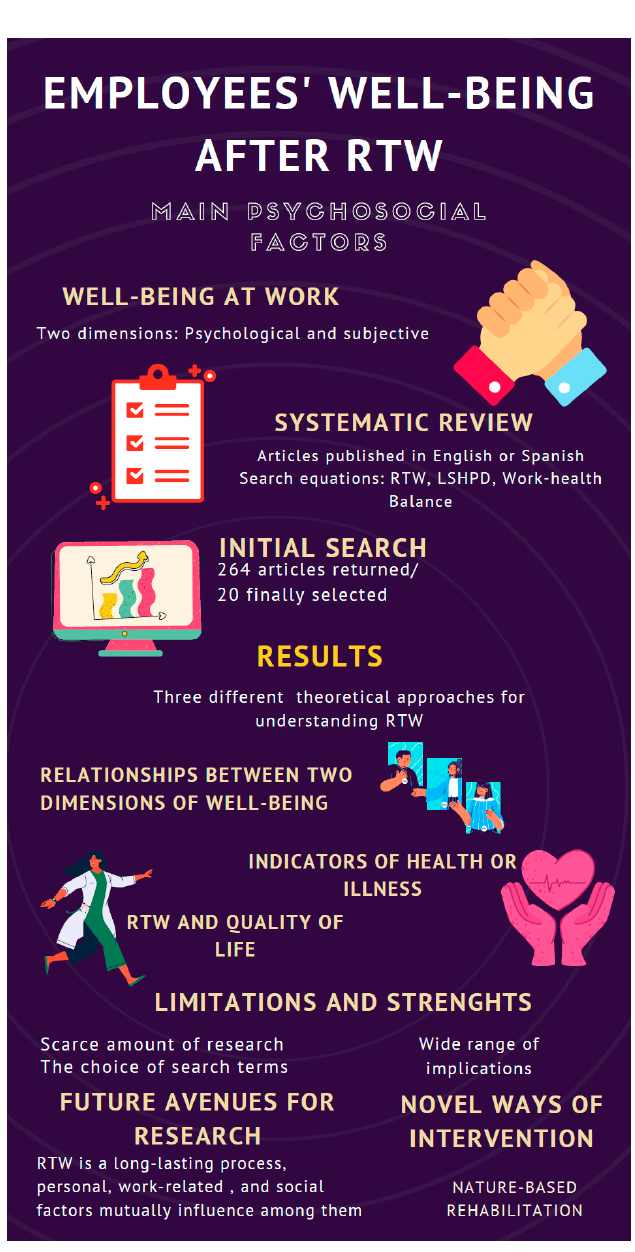
Figure 4. Graphical abstract.